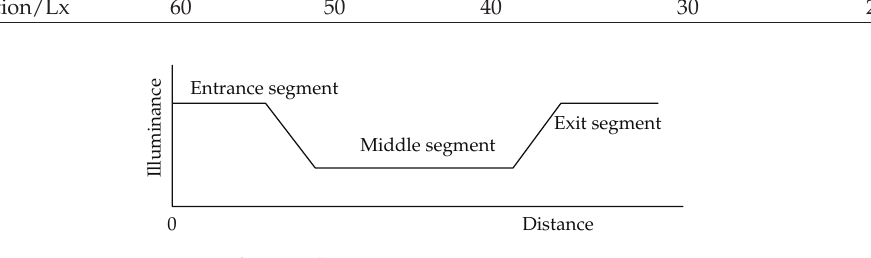
Figure 1: Luminosity variation pattern. Table 2: Membership grade between luminosity and fuzzy